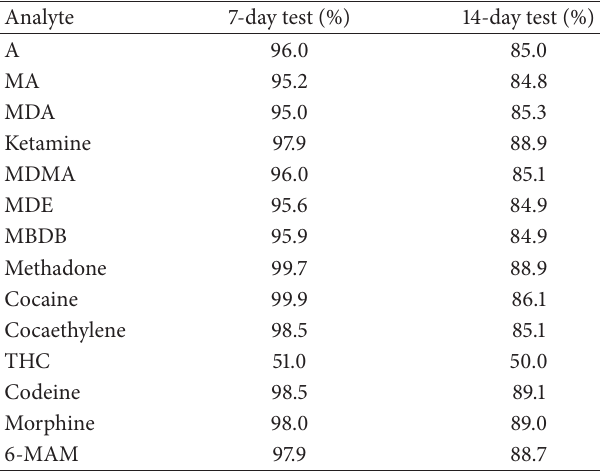
Table 4: Stability results at room temperature after 7-day and 14-day